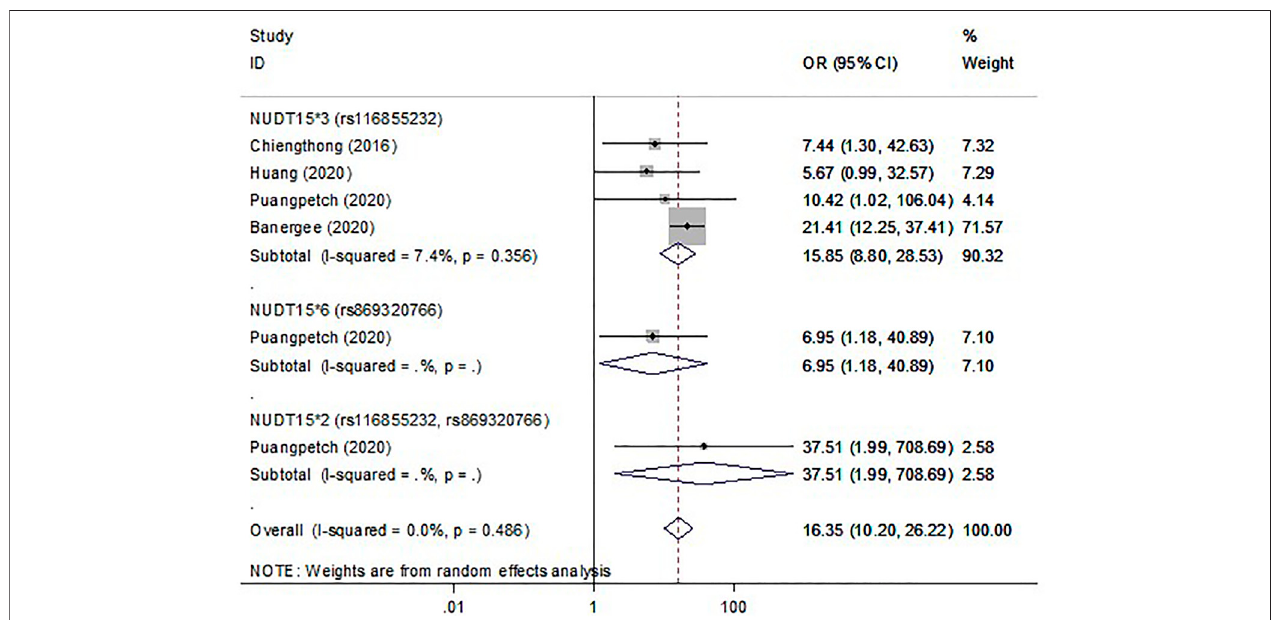
FIGURE3| Theforest plotsfor theassociation of NUDT15 variants withthiopurine-induced early neutropenia. Note: Width ofthe boxindicates theprecisionofthe estimates; diamond, the overall summary estimate for the analysis (width of the diamond represents the 95% CI) .